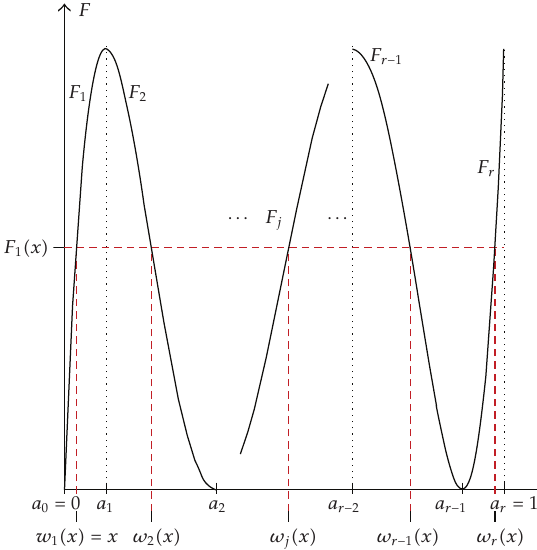
Figure 1: Illustration of branching